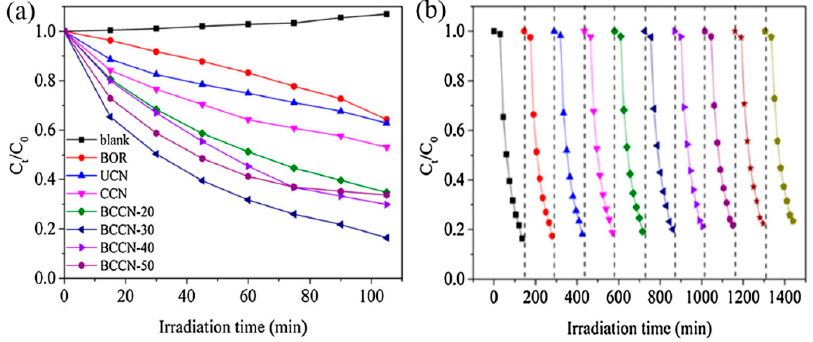
Figure 13. Photocatalytic activity ( a ) and recycling performance ( b ) of BCCN-30 for ciprofloxacin (CIP) degradation under visible-light irradiation (reproduced with permission from [91]. Copyright Elsevier, 2018).